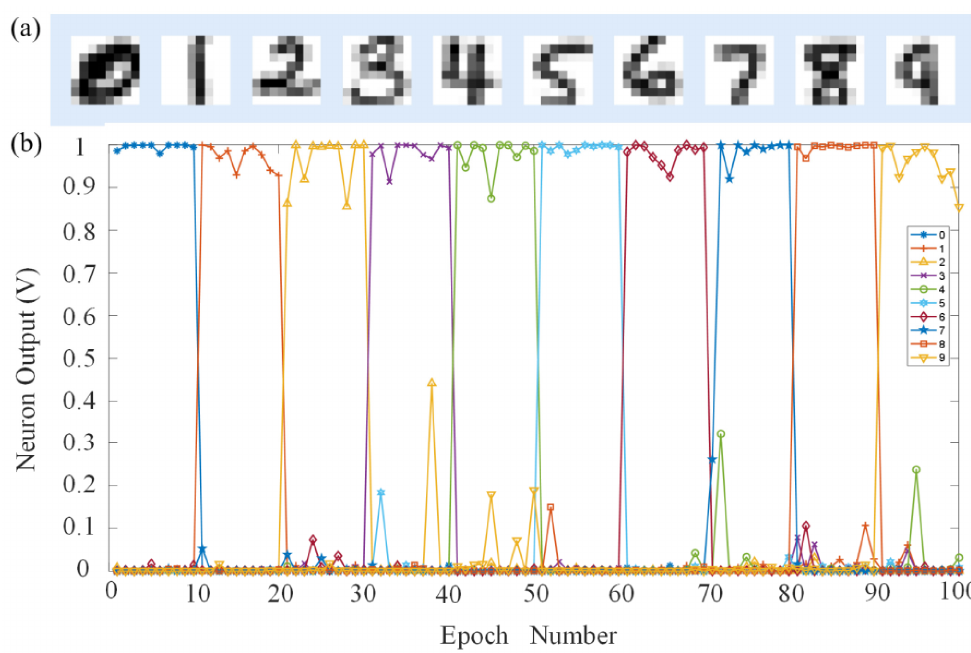
Figure 6. Pattern classification utilizing the dedicated memristor crossbar. ( a ) Handwritten digits from the MNIST database. ( b ) The evolution of output signals averaged over all patterns of a specific class.